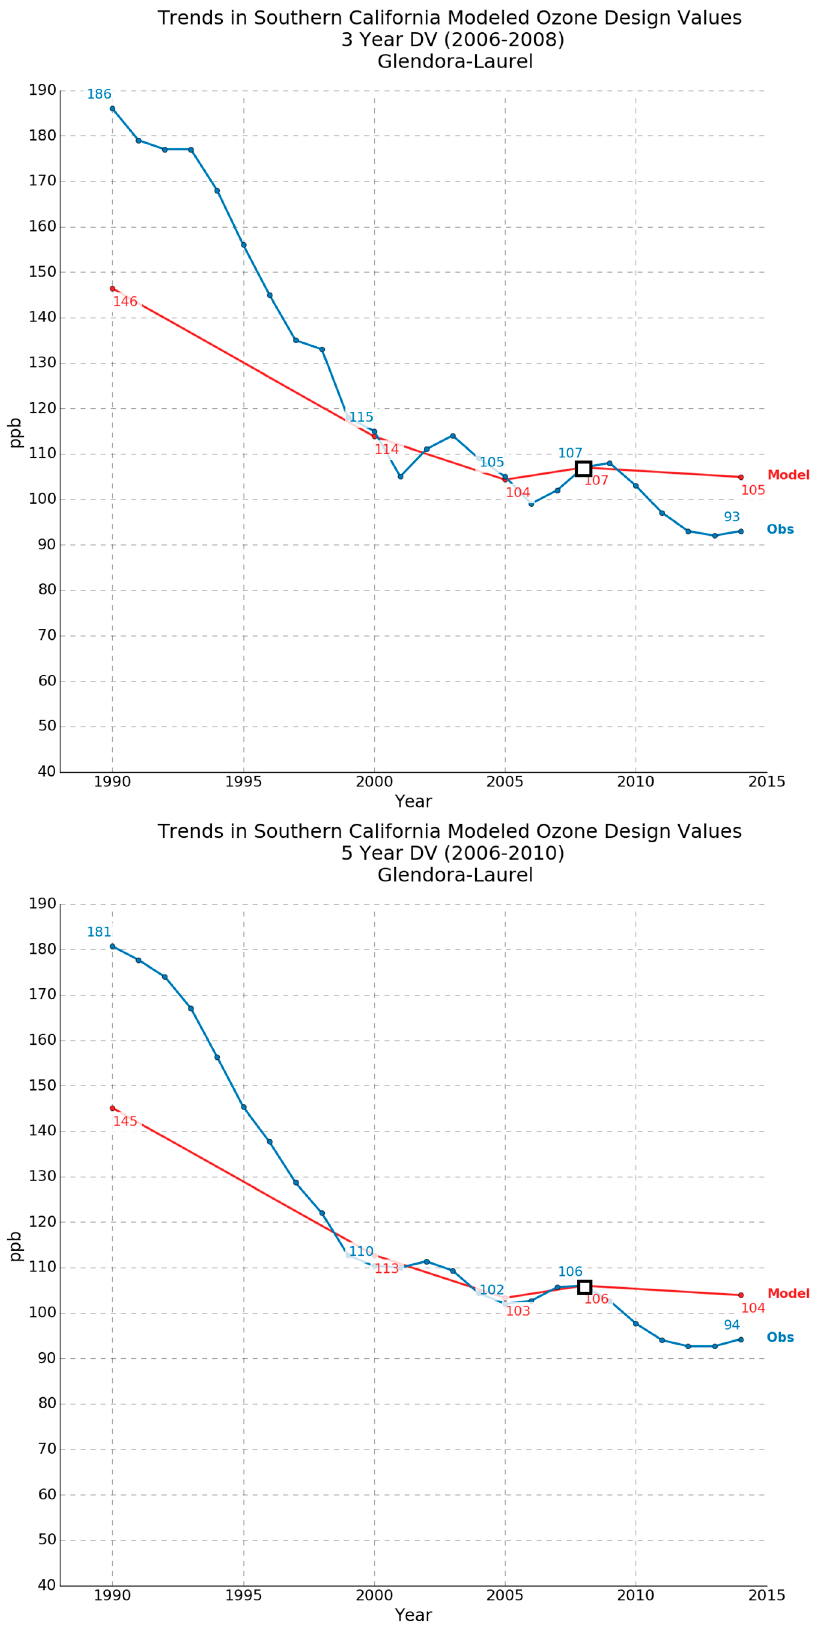
Figure 3. Modeled and observed trends in 3-year ( top ) and 5-year ( bottom ) ozone design values at the Glendora monitor from 1990 to 2014 using the 2012 AQMP modeling database. The anchor (baseline) year for the design value calculations is 2008 (marked by the square symbol in the figures).